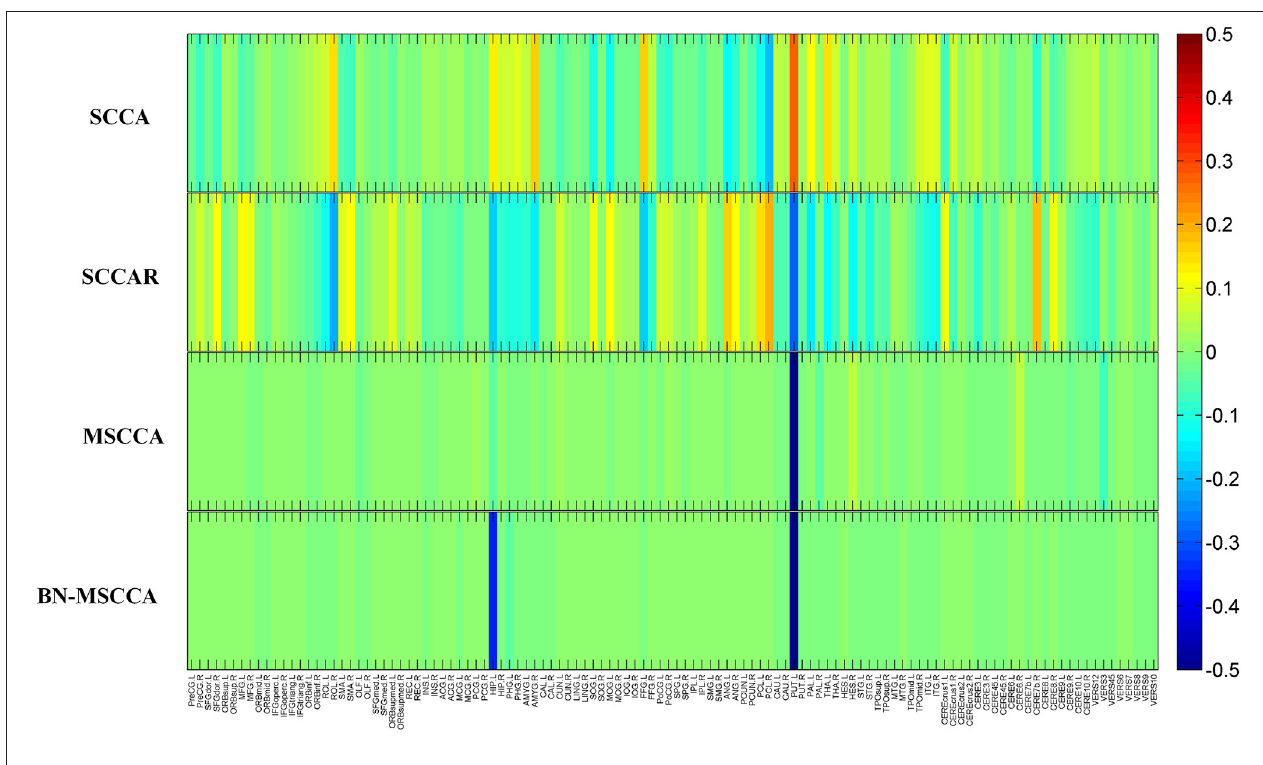
FIGURE 2 | The mean canonical weight U of d-fALFF during five times 5-fold cross-validation.